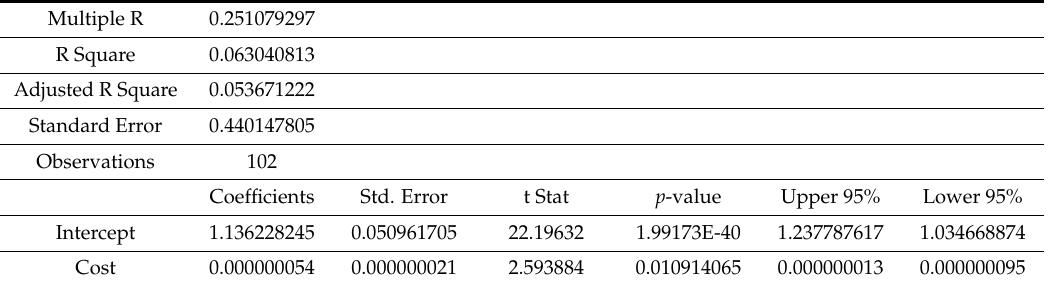
Table 5. Cost of green infrastructure project versus the number of financial tools.